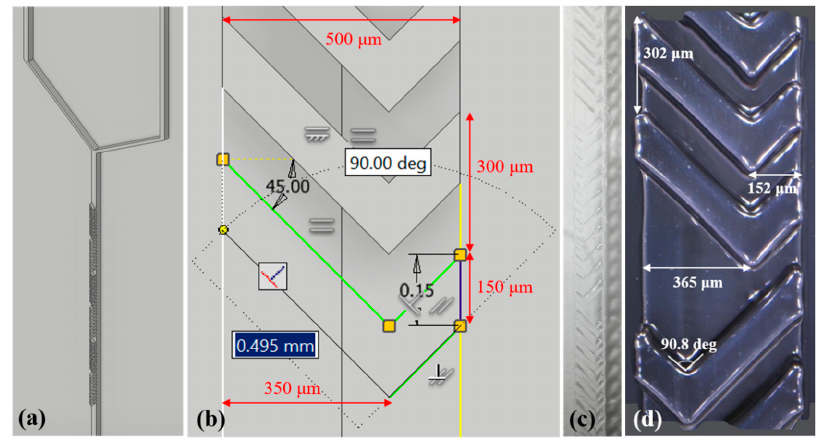
Figure 1. ( a ) Computer-aided design CAD model of the molds for polydimethylsiloxane (PDMS) with three cycles of staggered herringbone mixer (SHM) and ( b ) SHM geometry sketch details ( c ) and ( d ) optical images of the 3D-printed Y-channel mold for PDMS with a close-up at the SHM pattern.